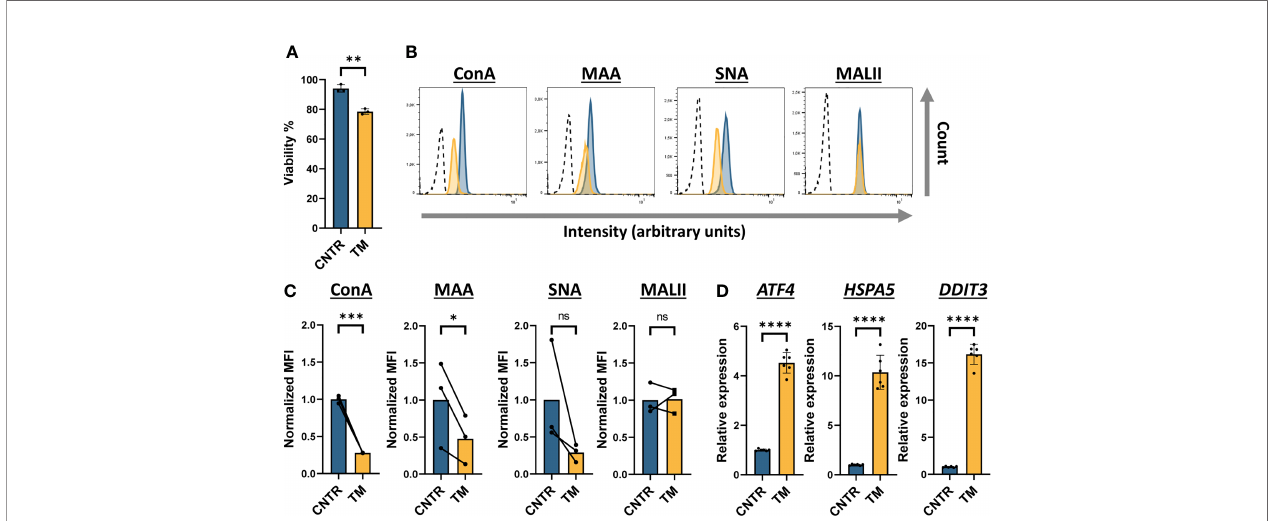
FIGURE 3 | Tunicamycin-treated THP-1 monocytes as a model to mimic PMM2-CDG THP-1 cells were treated with 10 ng/mL tunicamycin for 4 days (A) Viability of tunicamycin (TM) treated THP-1 cells assessed by fl ow cytometry after staining with propidium iodide (PI) (n = 3). (B) Histogram plots showing the intensity of fl uorescently labelled lectins (ConA, MAA, SNA and MALII) bound to THP-1 cells on a logarithmic scale. For simplicity, here we indicate only the unlabelled negative control (dotted line) related to sample CNTR as representative plot. (C) Quanti fi cation of the histogram plots showing the median fl uorescent intensity (MFI) normalized to the average MFI (set as 1) of the control (CNTR) (n = 3). Before normalization, the MFI values of the negative controls were subtracted. (D) Assessment of the ER stress response by measuring the RNA expression level of three ER stress components ATF4, HSPA5 and DDIT3 by qRT-PCR. The data was normalized to ACTB and GAPDH expression. Signi fi cance was calculated by a paired student ’ s t-test (A, D) or a ratio paired student ’ s t-test (C) . Mean ± S.D., ns, non-signi fi cant, * ≤ p-value 0.05, ** ≤ 0.01, *** ≤ 0.001, **** ≤